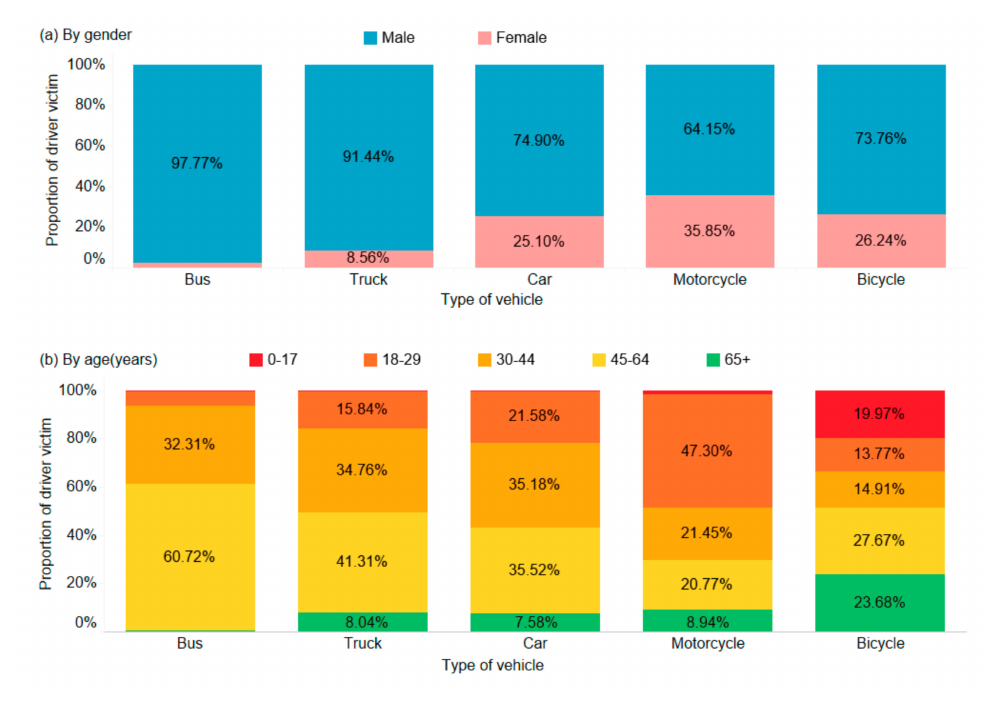
Figure 1. Proportion of driver victims involved in single-vehicle crashes according to vehicle type ( a ) by gender and ( b ) by